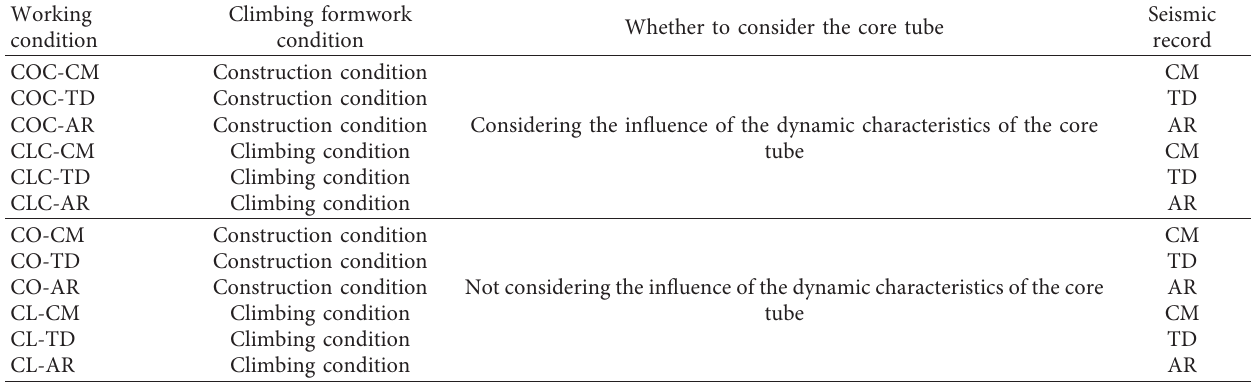
Table 4: Combination